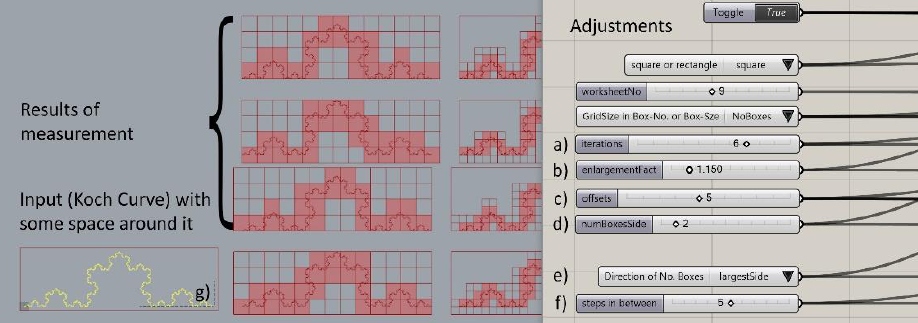
Figure 1. Box-counting with graphic macro programming in Grasshopper ® .